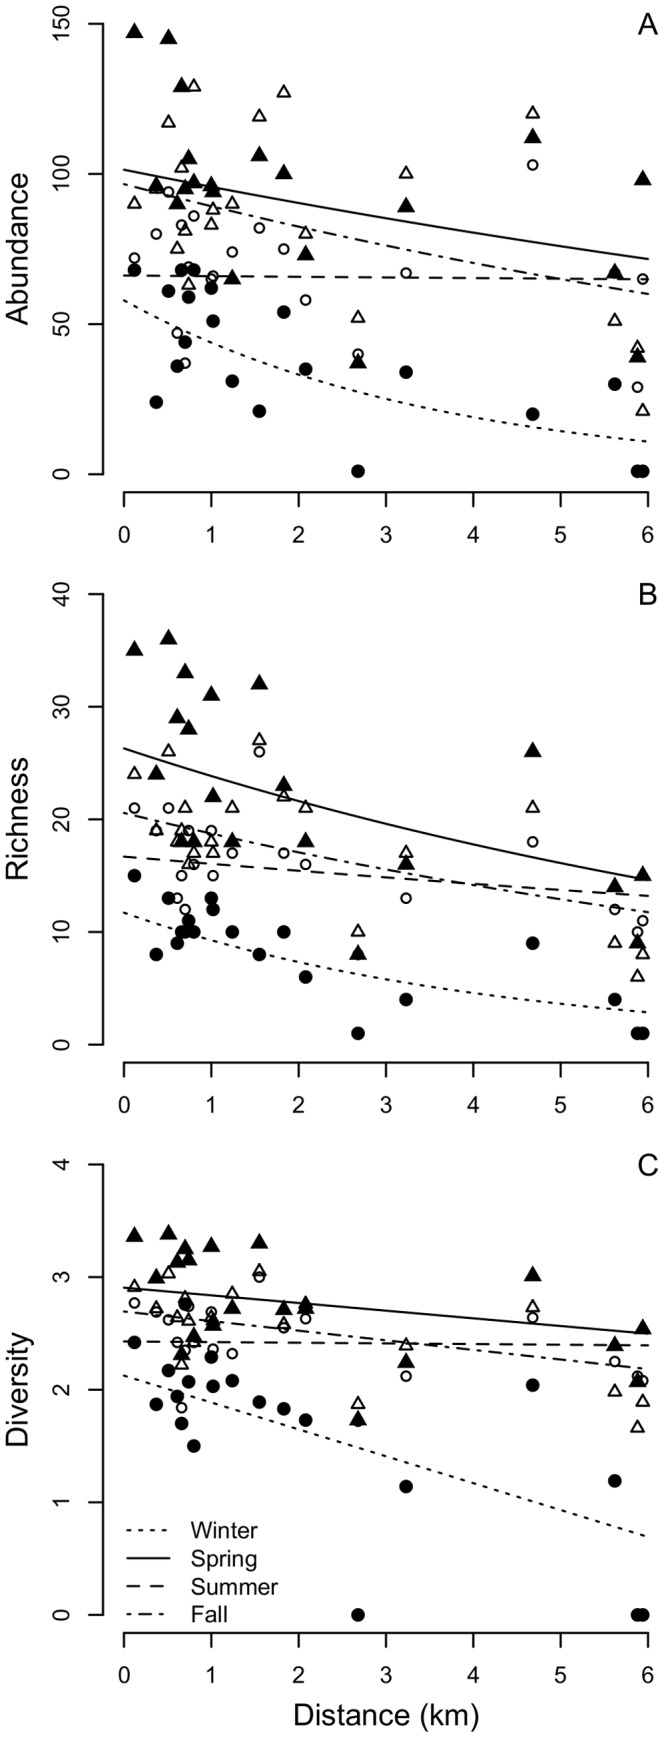
Effect of distance to vegetated lots on avian community structure.Relationships of avian (A) abundance, (B) richness, and (C) diversity are characterized for winter (closed circles), spring (closed triangles), summer (open circles), and fall (open triangles). Best-fit lines are indicated for each season and are based on parameter estimates from the most-supported models of each response variable (see Table 1).